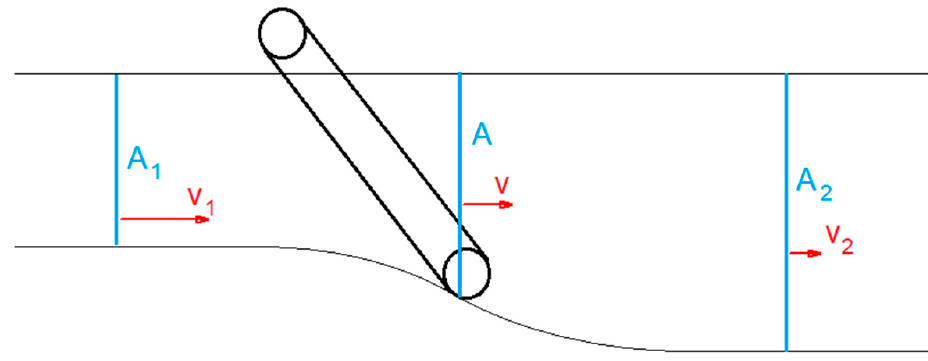
Figure 2. Fluid flow in the area of the ECB.